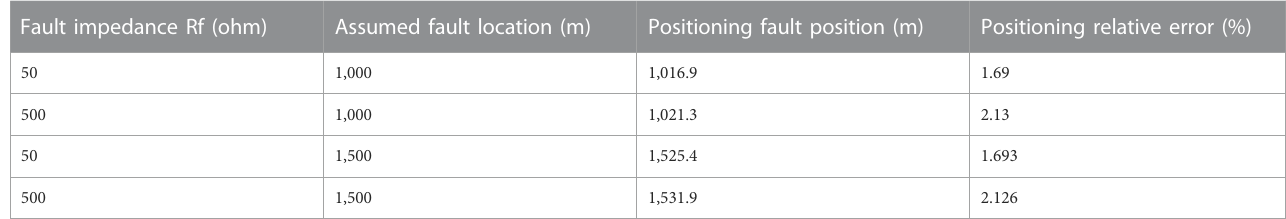
TABLE 4 Localization results of different fault impedances at different